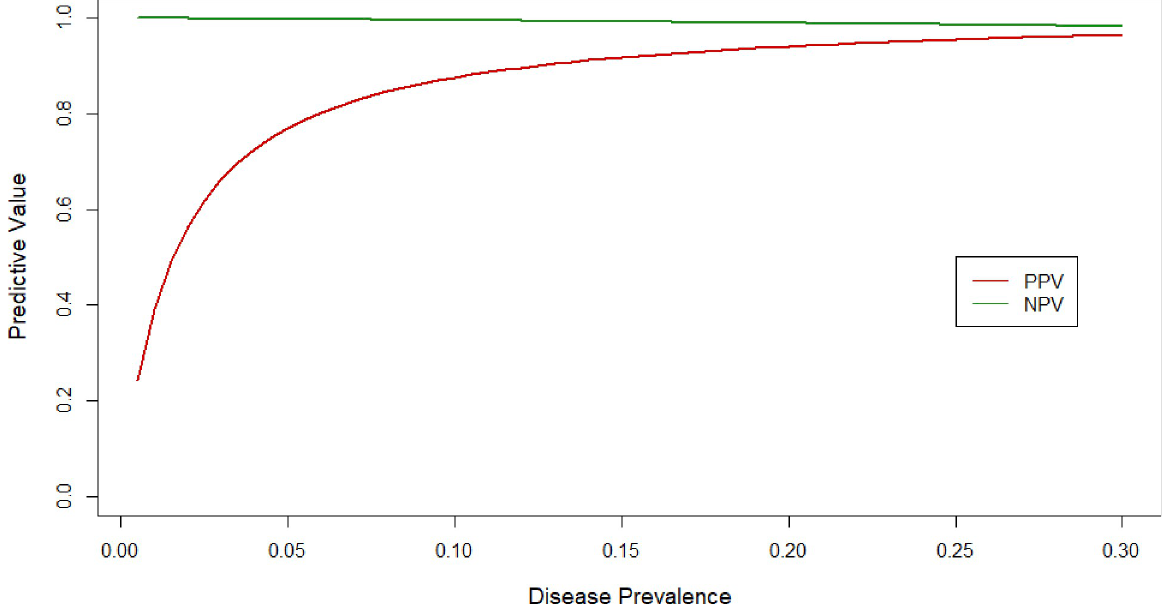
Fig 2. Positive (red line) and negative (green line) predictive values of Diagnostic Analyzer for Selective Hybridization (DASH) SARS-CoV- 2 PCR test by varying COVID-19 prevalence.